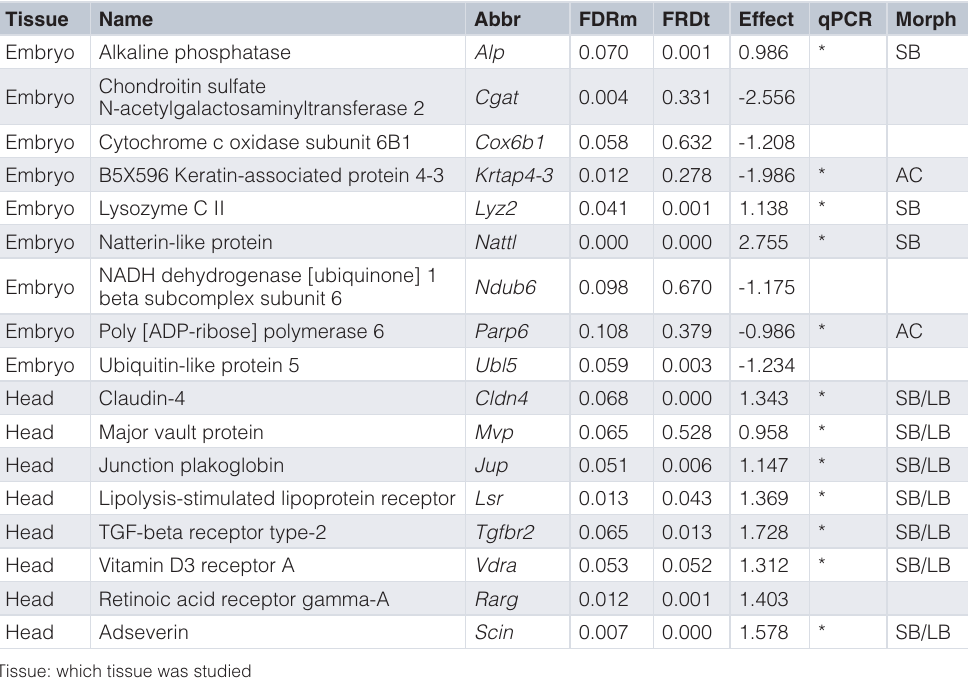
Table 3. Correspondence of transcriptome and qPCR verification on Arctic charr embryos. Tissue